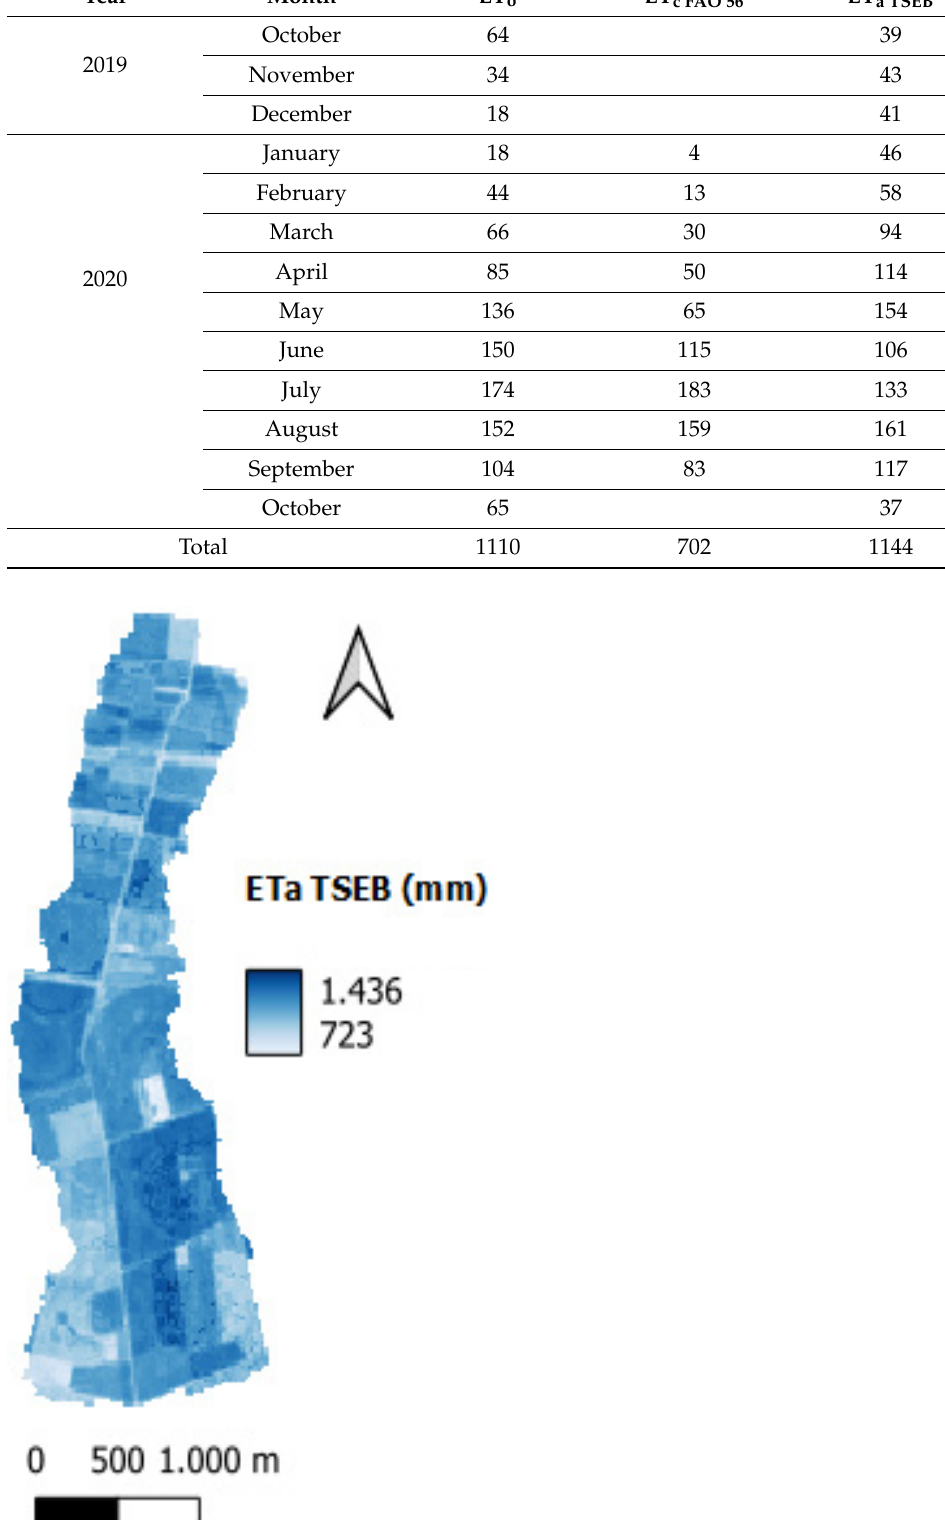
Figure 4. Cumulative ET a TSEB during the study period in the AB5 sub-basin.